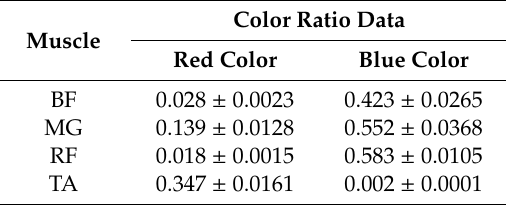
Figure 5. Acquired quantitative color ratio data using our developed program for the major lower limb muscles. Table 1. Quantitative evaluation results for color ratio data for red and blue for the major lower limb muscles.